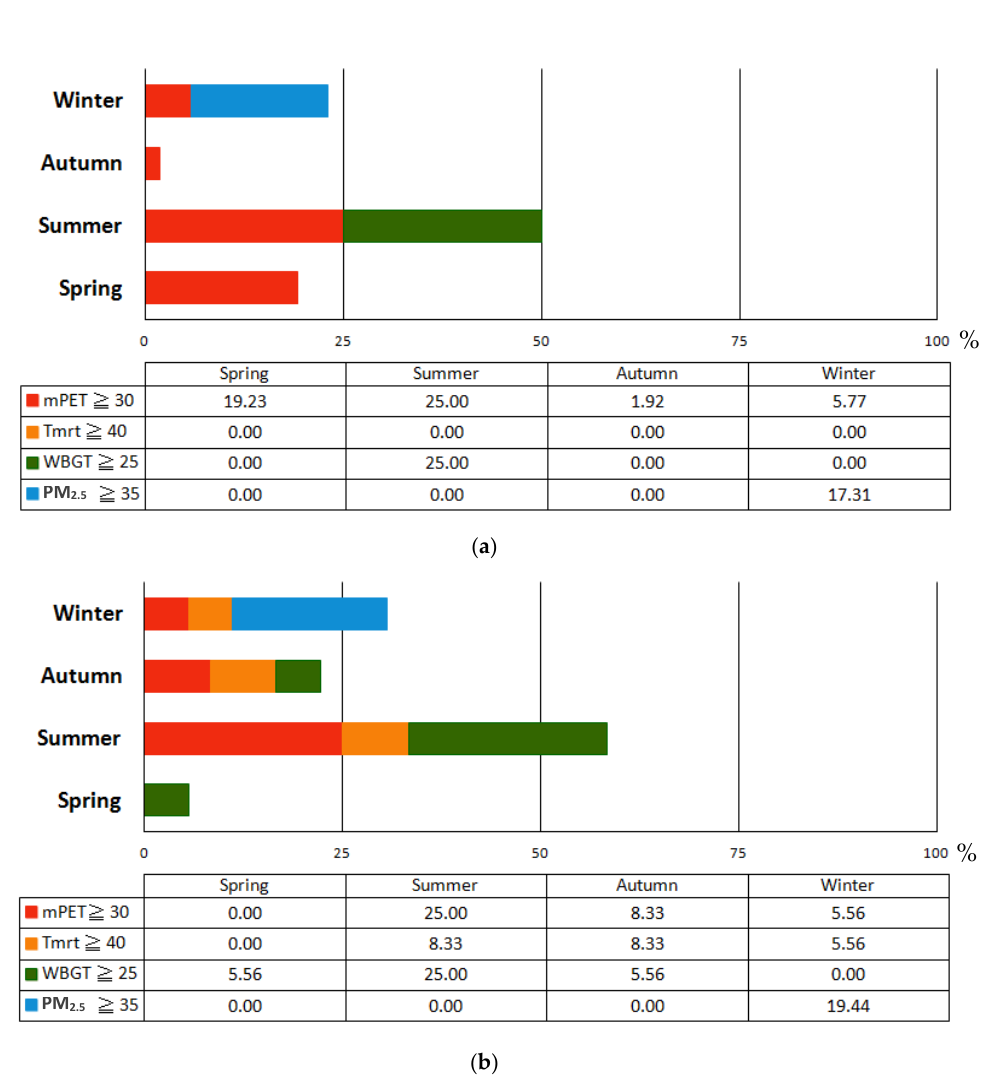
Figure 15. Discomfort risk for runners ( a ) and walkers ( b ).